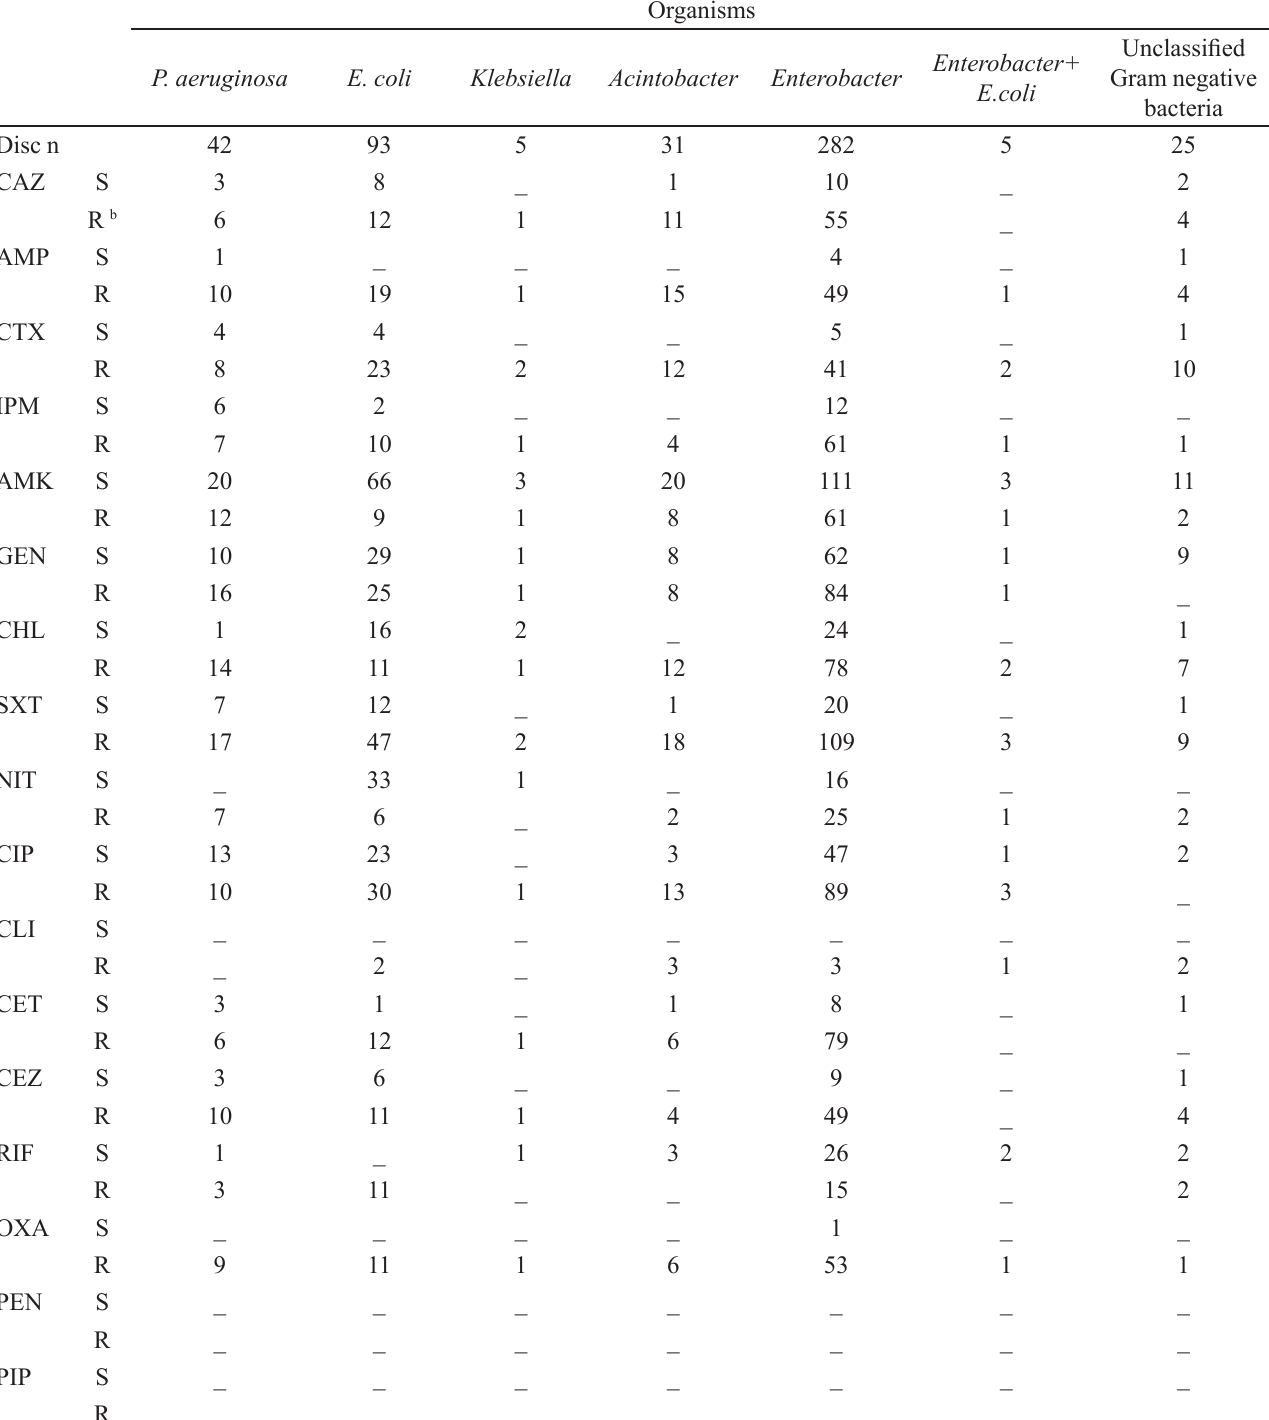
TABLE III - Susceptibility rates of Gram-negative bacilli isolated from the ICU